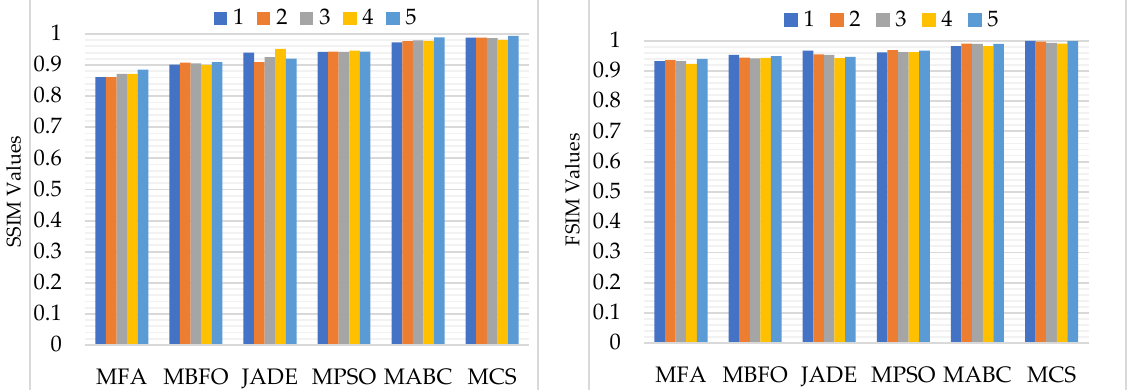
Figure 15. MSE and PSNR using different optimization algorithms with Rényi’s entropy. Table 10. MSE and PSNR using different optimization algorithms with Rényi’s entropy.